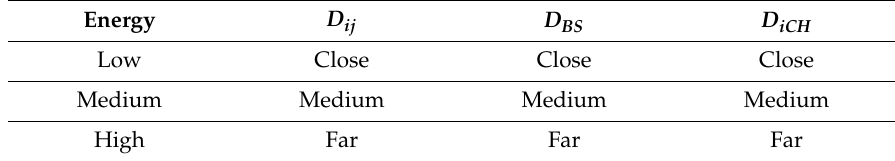
Table 2. Linguistic variables.